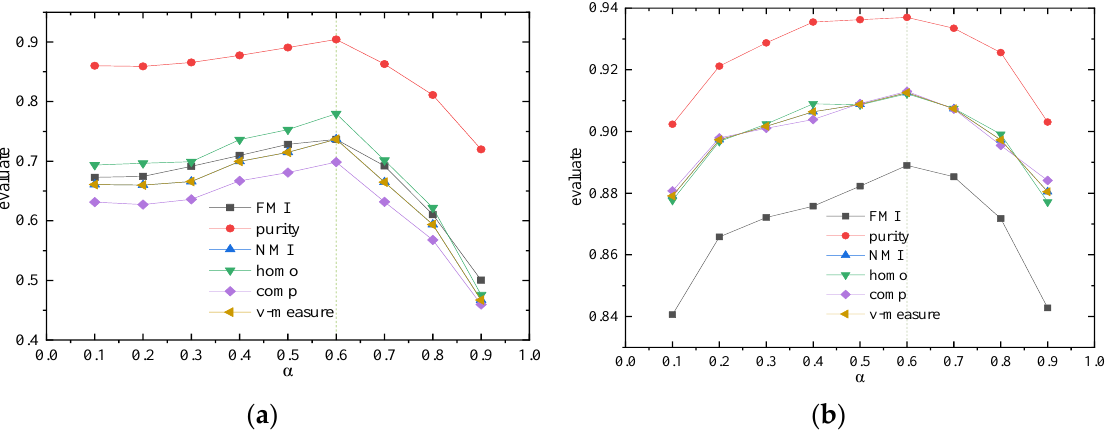
Figure 3. Avg evaluation results of different α values in the real-world datasets. ( a ) Avg evaluation of different α with CW. ( b ) Avg evaluation of different α with PS.